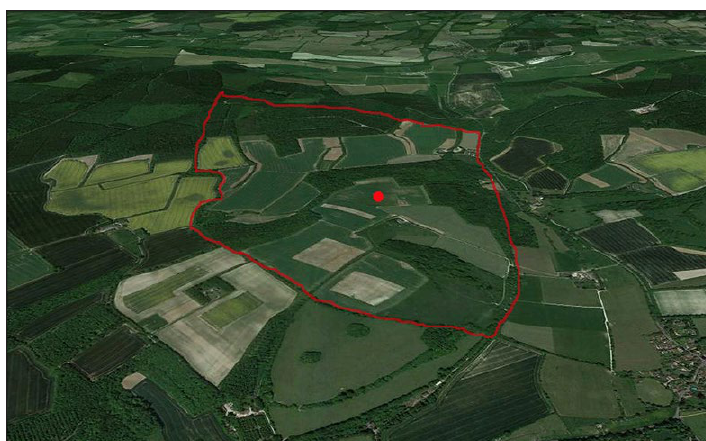
Figure 2: Oblique view of Downley Park looking NW. The house is located in the centre of the park, marked by the red dot. Park parameters are given in the text. [Underlay Google